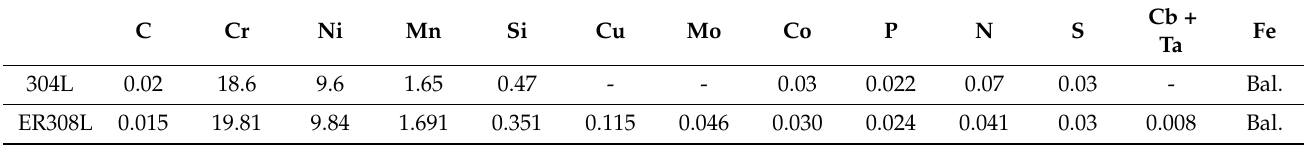
Table 1. Chemical composition of 304L stainless steel and filler metal (wt %) [18].